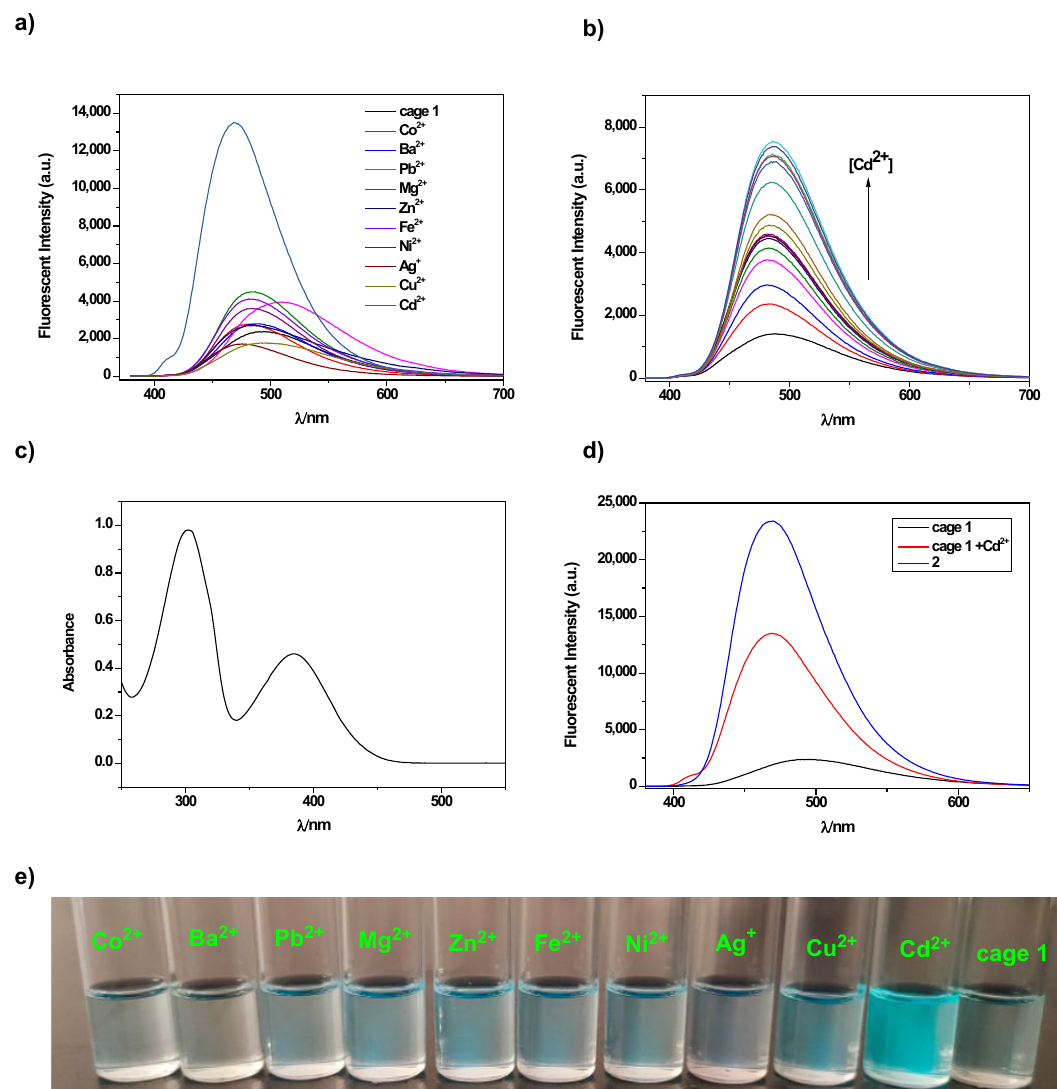
Figure 3. ( a ) Fluorescence emission spectra of cage 1 after the addition of 10 equiv of various metal cations in the mixture solvent of CHCl 3 and CH 3 CN ( v / v = 10:1) at 295 K. Excitation at 372 nm. [ 1 ] 0 = 1.0 × 10 −5 M. ( b ) Emission spectra (λ ex = 372 nm) of 1 (5.0 × 10 −6 M) in the presence of Cd 2+ in the mixture solvent of CHCl 3 and CH 3 CN ( v / v = 10:1) at 295 K. The concentration of Cd 2+ for curves from top to bottom are 0, 0.5 (0.1 eq of 1 ), 1.0 (0.2 eq of 1 ), 1.5 (0.3 eq of 1 ), 2.0 (0.4 eq of 1 ), 2.5 (0.5 eq of 1 ), 3.0 (0.6 eq of 1 ), 3.5 (0.7 eq of 1 ), 4.0 (0.8 eq of 1 ), 4.5 (0.9 eq of 1 ), 5.0 (1.0 eq of 1 ), 6.0 (1.2 eq of 1 ), 7.0 (1.4 eq of 1 ), 8.0 (1.6 eq of 1 ), 10.0 (2.0 eq of 1 ), 12.0 (2.4 eq of 1 ), and 15.0 (3.0 eq of 1 ) (× 10 −6 M). ( c ) UV–visspectrum of cage 1 . [ 1 ] 0 = 1.0 × 10 −5 M. ( d ) Fluorescence emission spectra of 2 , cage 1 , and 1 - Cd 2+ . [ 2 ] 0 = 1.0 × 10 −5 M, [ 1 ] 0 = 1.0 × 10 −5 M. ( e ) Photograph of the solutions used for ( a ) under a 365